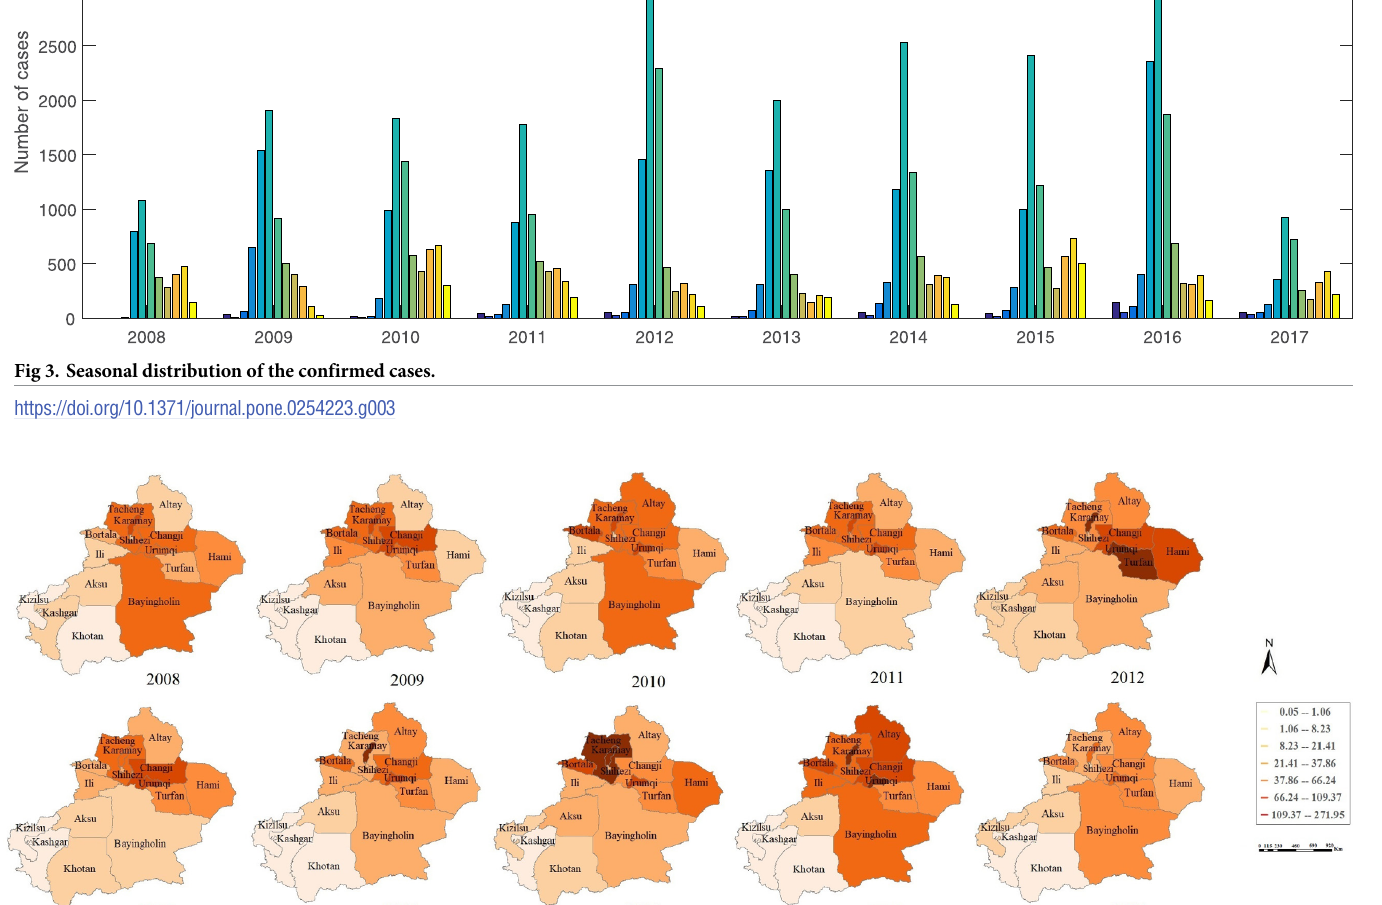
Fig 4. Spatial distribution of the confirmed incidences. It is generated by software ArcGIS 10.2 from http://eol.jsc.nasa.gov/SearchPhotos/.